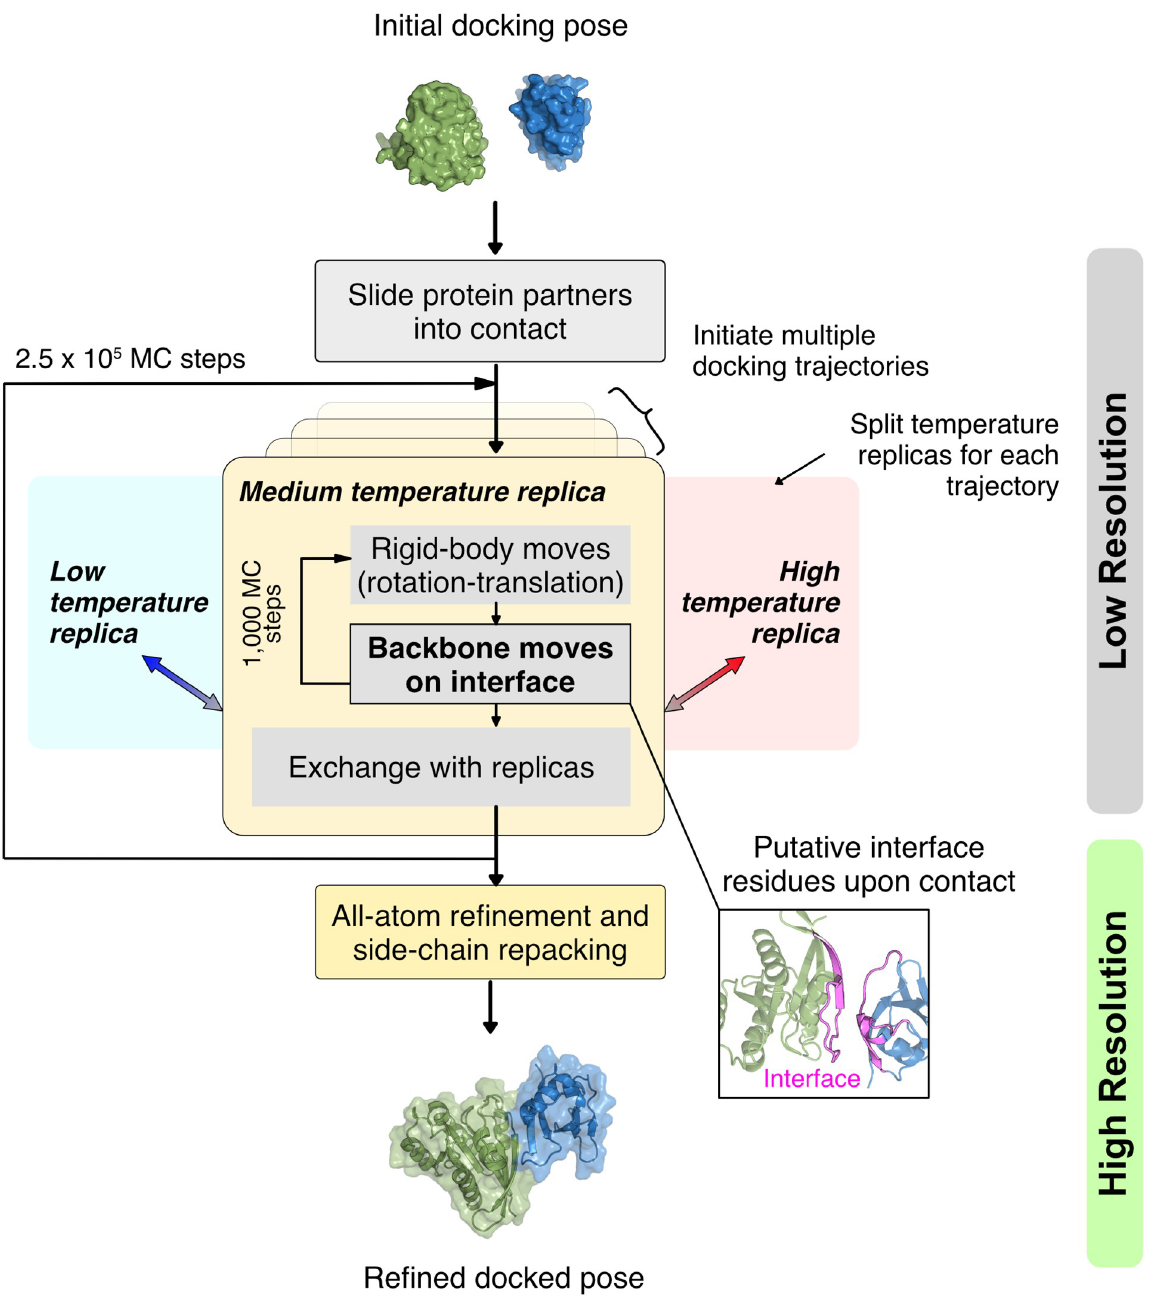
Fig 1. Overview of the ReplicaDock2 protocol. Starting from an initial docking pose i.e. a structural model with randomly oriented protein partners, the protocol perturbs the protein partners and slides them into contact. This creates an initial docking pose for the low-resolution stage. Here, the pose object is copied to three parallel replicas per trajectory, and each replica performs rigid body moves (rotation-translation) and backbone moves for each MC trial, followed by exchange between replicas after every 1,000 th trial. Each exchange obeys the Metropolis acceptance criterion and if accepted, the low resolution structure is output. Each trajectory completes 2.5 × 10 5 MC trial steps, and produces * 5,000 candidate structures. Lastly, all produced structures undergo an all-atom refinement comprising of side-chain packing, small rigid-body motions, and energy minimization to output final docked structural